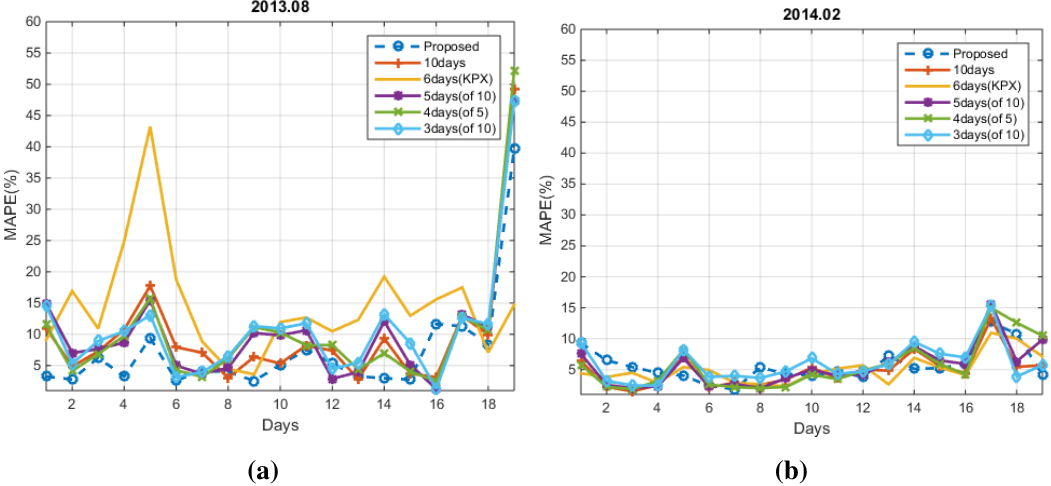
Figure 11. Mean absolute percentage error ( MAPE ) evaluation of site A in summer season ( a ) and winter season ( b ).